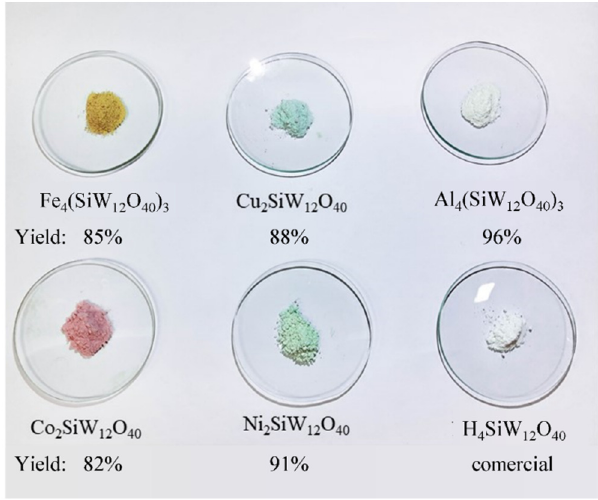
Figure 1. The yield of synthesis of the metal-exchanged silicotungstic acid salts [27]. 2.2. Synthesis of Phosphotungstic, Phosphomolybdic, and Silicotungstic Acids Lacunar Salts